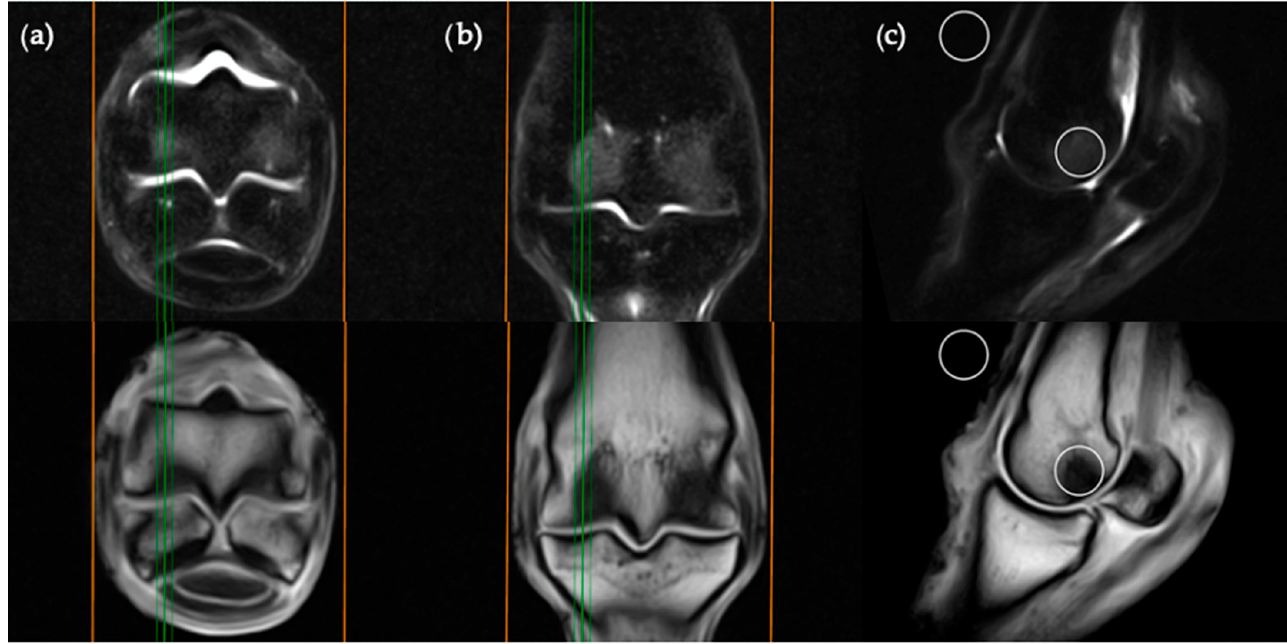
Figure 3. STIR FSE (top row) and T1W GRE (bottom row) MRI images in ( a ) transverse; ( b ) frontal and ( c ) sagittal planes; demonstrating the location of condylar ROI placement in a parasagittal plane. The green lines on the transverse and frontal images show the standardized orientation and location of the medial or lateral condylar parasagittal slices for ROI placement. The orange lines show the extent and orientation of all the sagittal slices acquired in the MRI study.